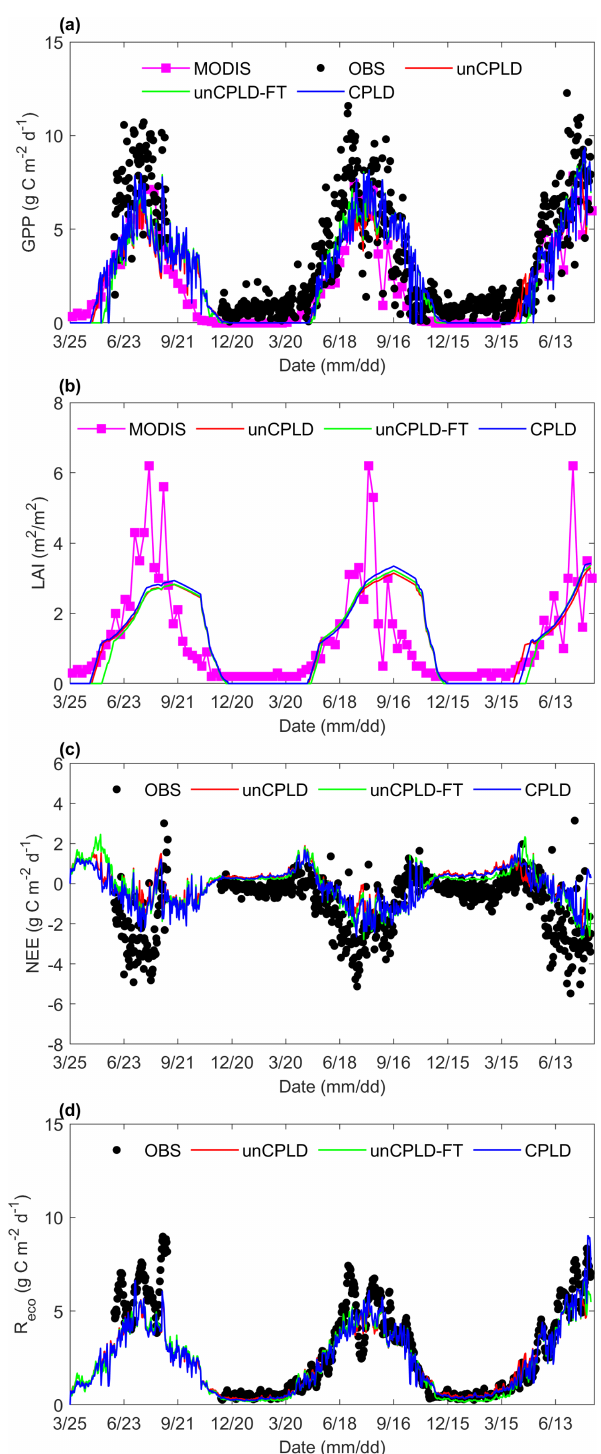
Figure 9. Comparison of observations from eddy covariance (OBS) or MODIS remote sensing and simulated (a) gross primary produc- tion (GPP), (b) leaf area index (LAI), (c) net ecosystem exchange (NEE), and (d) ecosystem respiration ( R eco ) using the unCPLD, unCPLD-FT, and CPLD models. MODIS refers to the data from MODIS-GPP and MODIS LAI